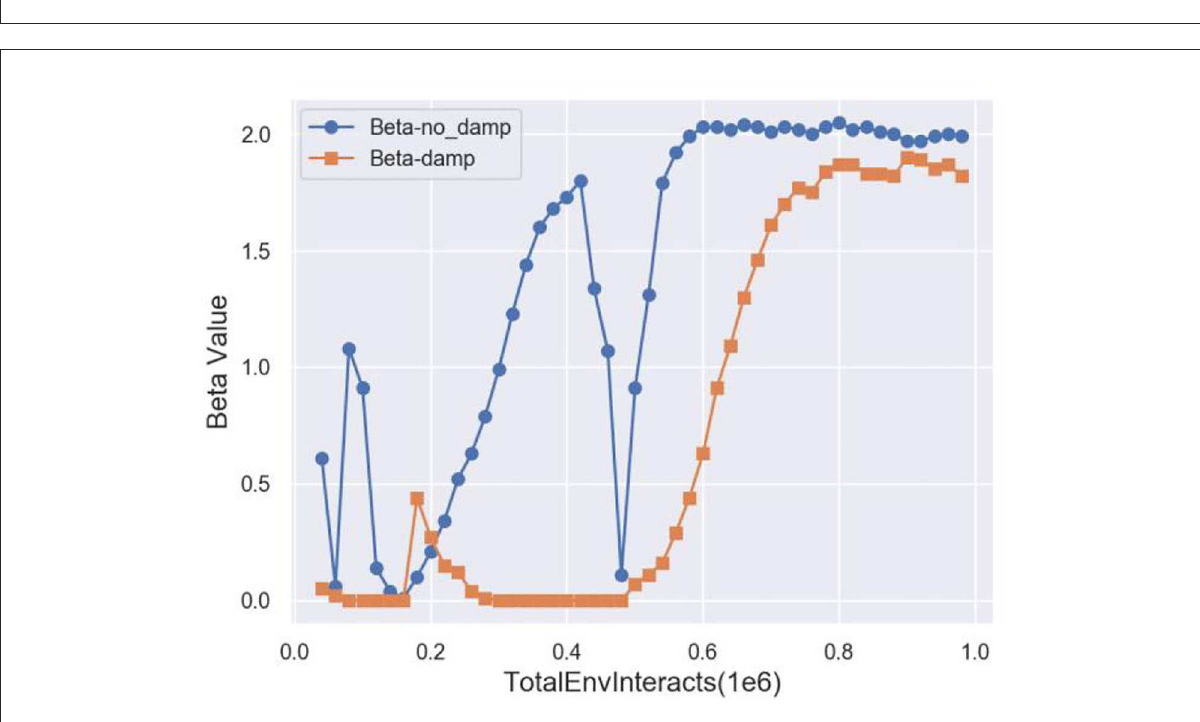
FIGURE8 Cost coefficient